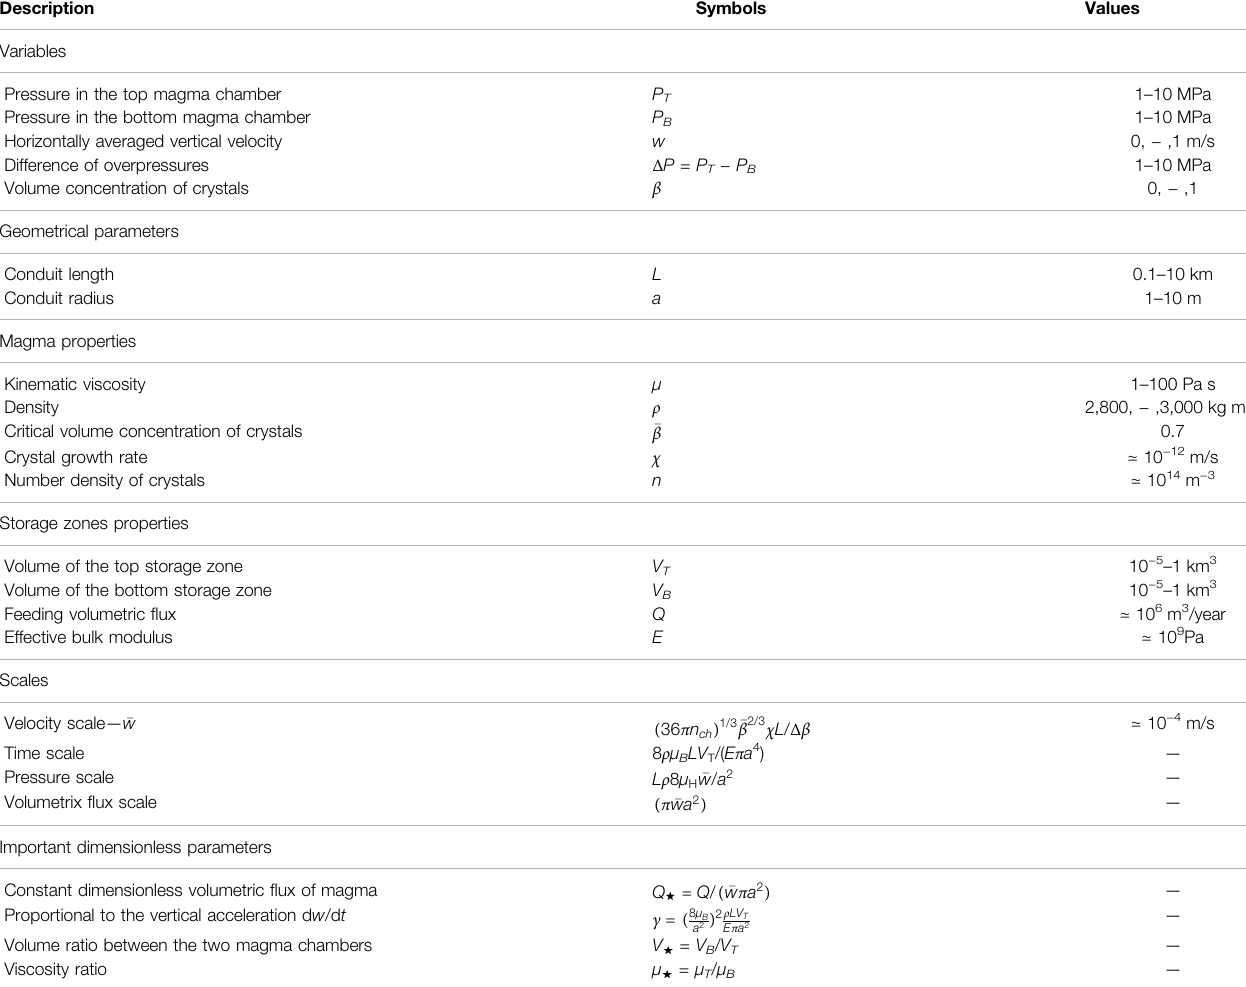
TABLE 2 | List of main variables and parameters described in the main text and appearing in the proposed physical model of Section 5.2 .